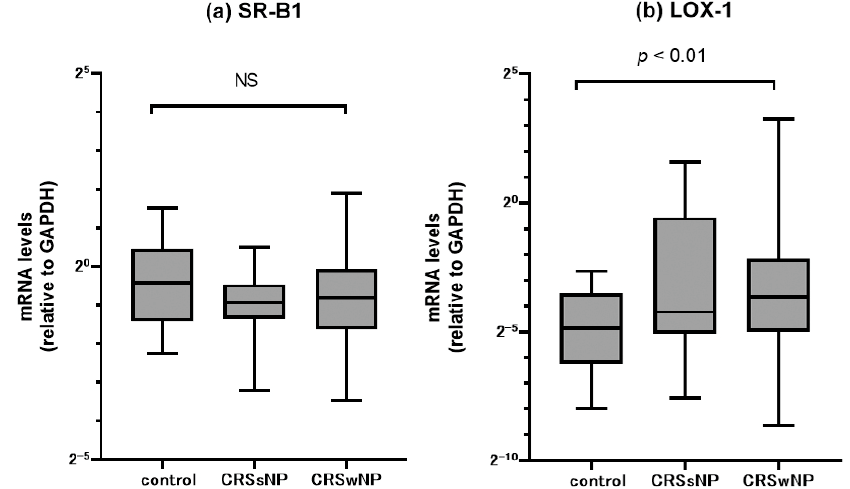
Figure 1. Comparison of mRNA expression in paranasal sinus mucosa from the controls, and CRSsNP and CRSwNP patients as detected by RT-PCR. ( a ) scavenger receptor class B type 1 (SR-B1) and ( b ) lectin-like oxidized LDL receptor-1 (LOX-1) mRNA levels were quantitatively normalized to the glyceraldehyde 3-phosphate dehydrogenase (GAPDH) mRNA levels. Center lines: median values. Boxes: interquartile ranges. Error bars: overall ranges. NS: not